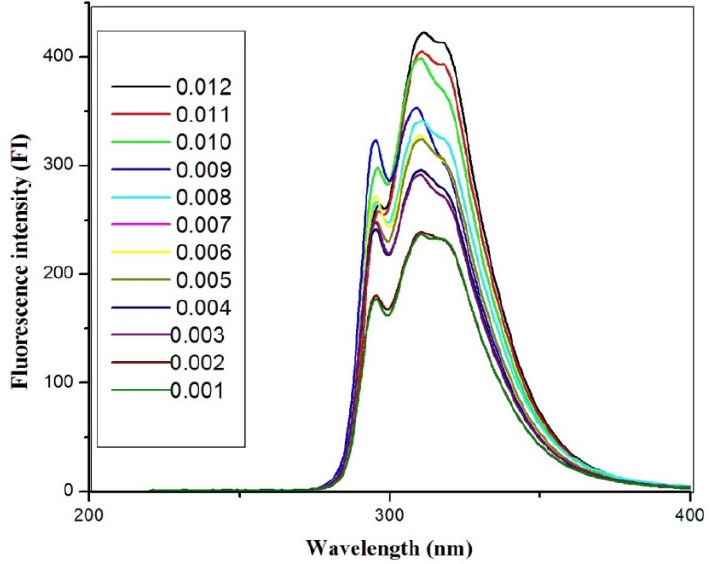
Figure 4. Fluorescence intensities (FI) versus wavelength for pre ‐ micellar concentrations of SDS in CAD + E ‐ OH .